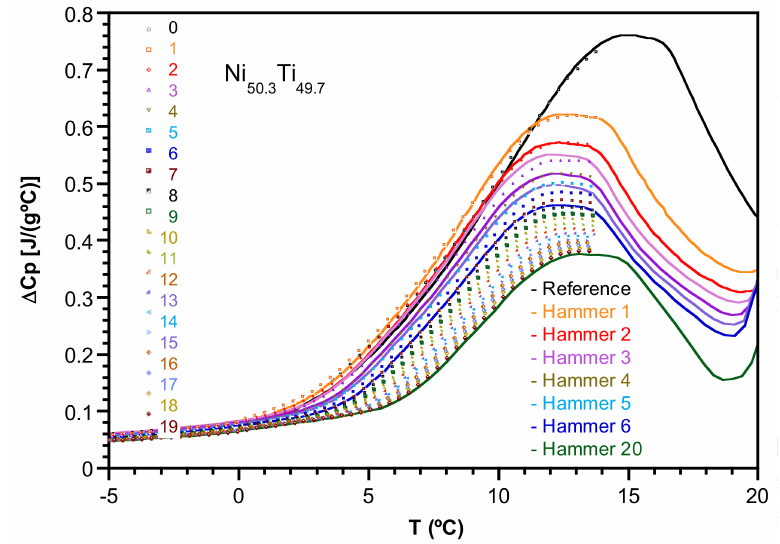
Figure 11. The points represent the partial 20 heating runs ( ps = 0, 1, . . . , 19) previous to the “Hammer 20” curve. The continuous lines are the “Hammer n ” curves for n =1–6 and n = 20 also shown in Figure